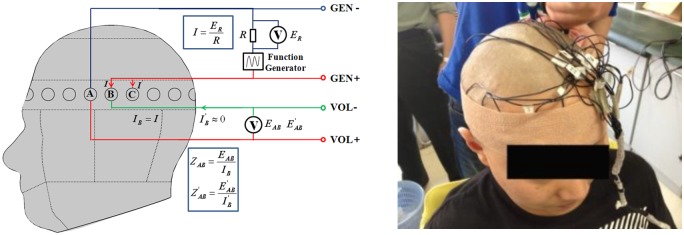
Measuring circuit of contact impedance.In this study, an impedance analyzer was used, and the voltage excitation mode (500 mV) was applied.